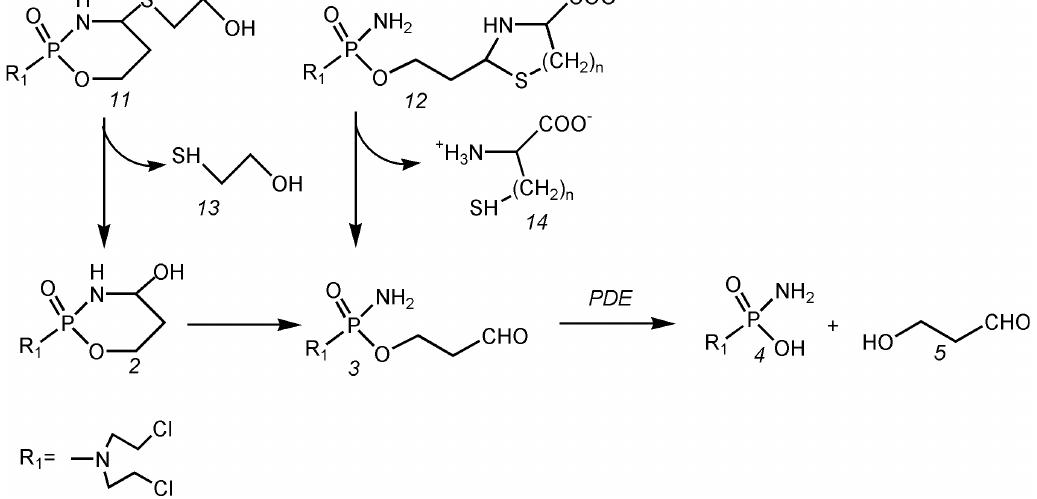
Figure 4. Hydrolysis of 4-(S-ethanol)-cyclophosphamide ( 11 ) via OHCP and direct hydrolysis of aldophosphamide thiazolidine ( 12 n = 1) and aldophosphamide perhydrothiazine ( 12 n = 2) to aldophosphamide ( 3 ) and enzymatic cleavage of aldophosphamide to phosphoreamidemustard ( 4 ) and hydroxypropanal ( 5